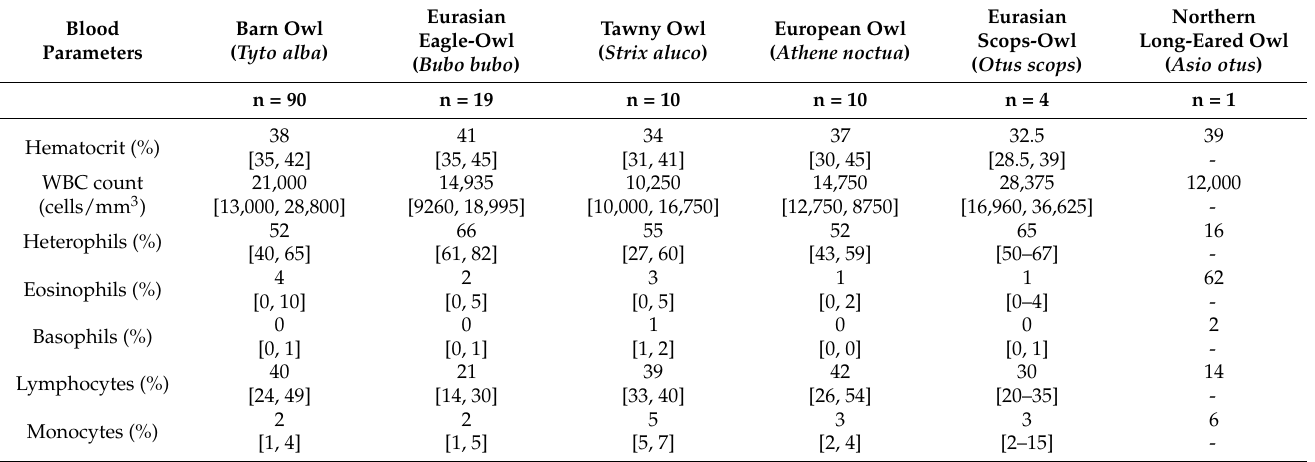
Table 2. Hematological results according to bird species. Results are expressed with median and quartiles [Q1,